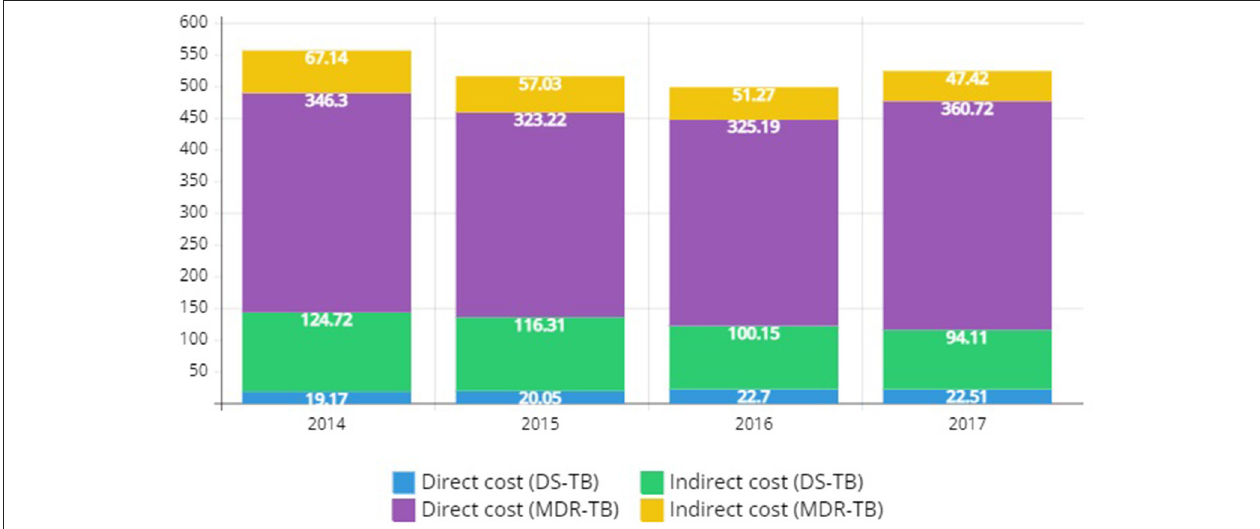
FIGURE 2 | Economic disease burden of drug-susceptible tuberculosis and multidrug-resistant tuberculosis in Korea, 2014–2017 (Discount rate: 3%, Unit: $1